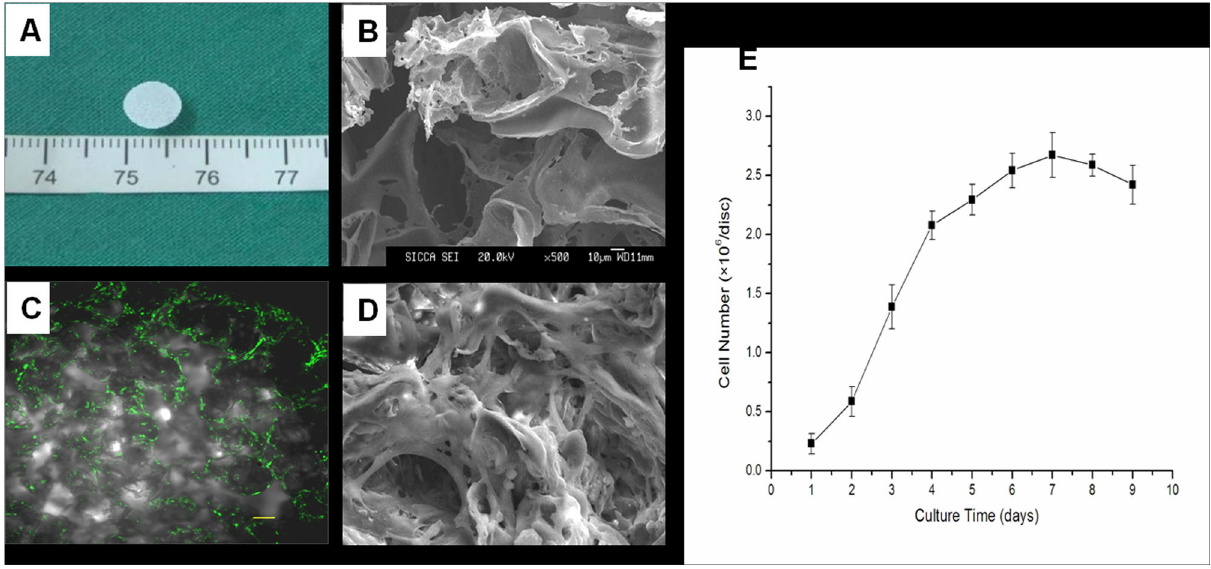
Figure 2. Proliferation and distribution of rASCs on a PLGA scaffold and secretion of the extracellular matrix (ECM). (A) Gross view of the PLGA scaffold with a 7 mm diameter. (B) Scanning electron micrograph (SEM) images of PLGA scaffold without cells. (C) The view of the rASCs and PLGA scaffold at 7 days was observed by confocal microscopy to reveal the cell distribution on the scaffold (Bar scales: 20 µm). (D) Attachment of rASCs on the same PLGA scaffold and deposition of the ECM are shown by SEM (magnification×500). (E) The quantitative evaluation of the proliferation of rASCs seeded on the PLGA scaffold determined by DNA assay using Hoechst33258 dye. Abbreviations: rASCs, rabbit adipose stem cells; PLGA, polylactic-co-glycolie acid; SEM, scanning electronic microscope. doi: